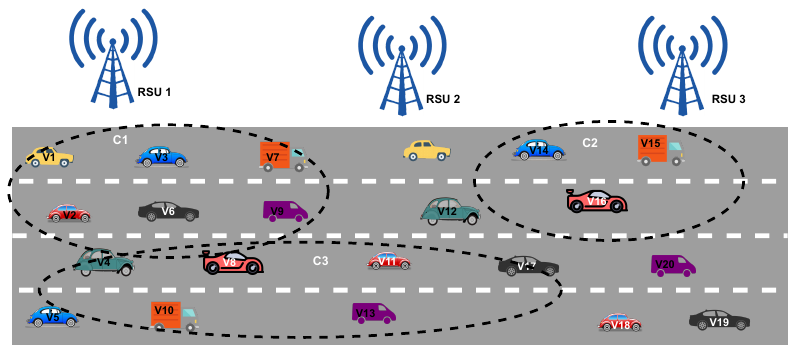
( a ) Proposed Scheme clustered Vehicles. Figure 4. Cont